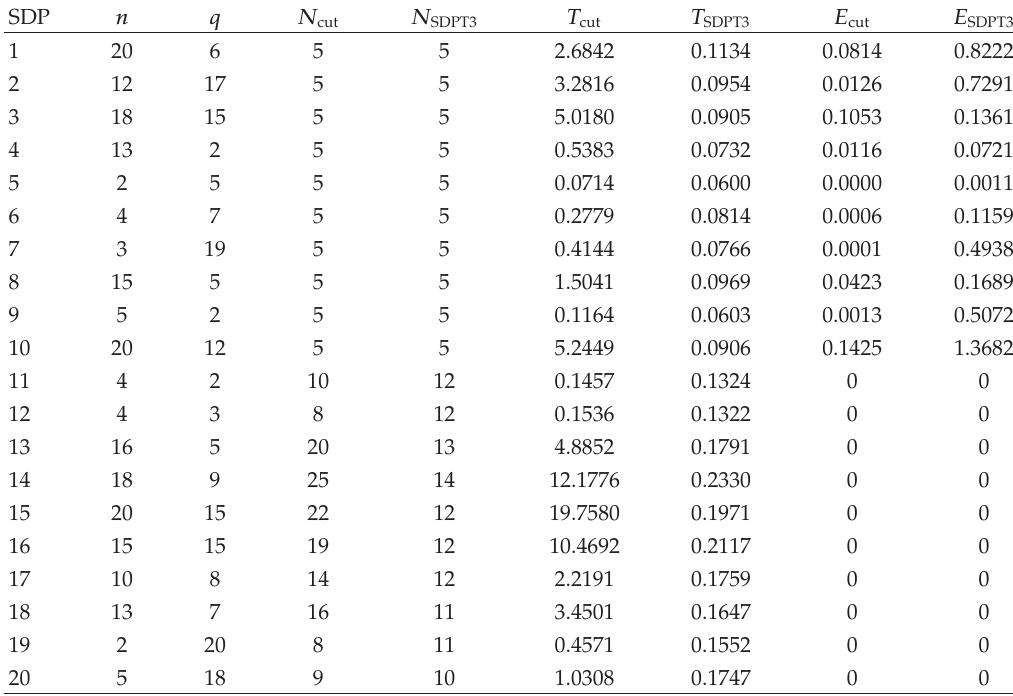
Table 1: Data for experiment II: SDP-CUT versus